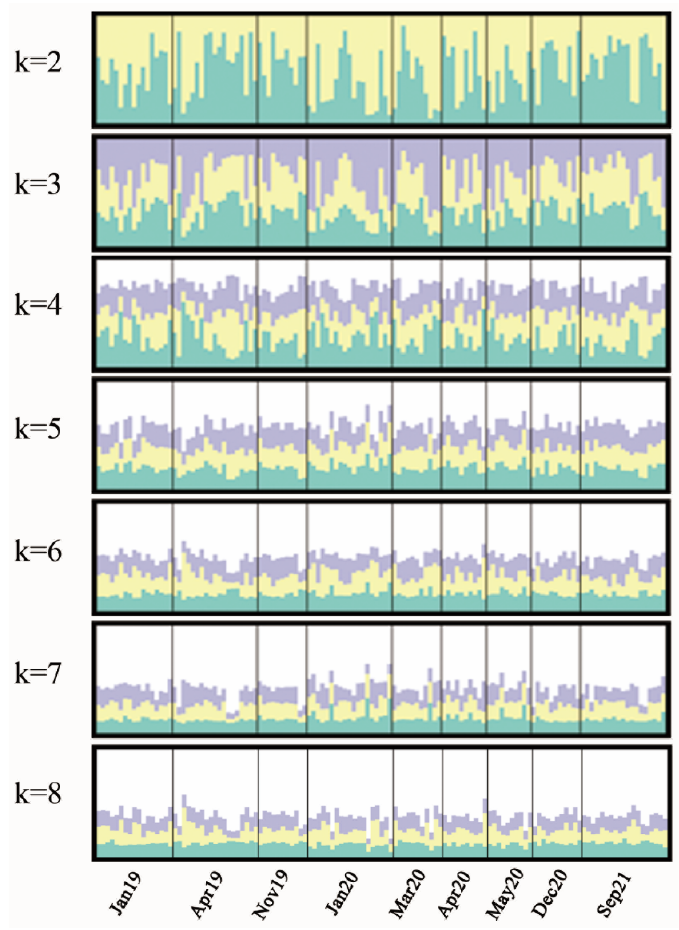
Figure 2. Bayesian clustering of Anguilla japonica temporal samples under assumption of K = 2–8, using STRUCTURE v2.3.4. Graphics were generated with DISTRUCT and CLUMPP. Jan19 = January